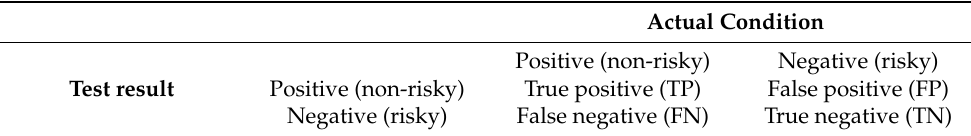
Table 1. Confusion matrix.